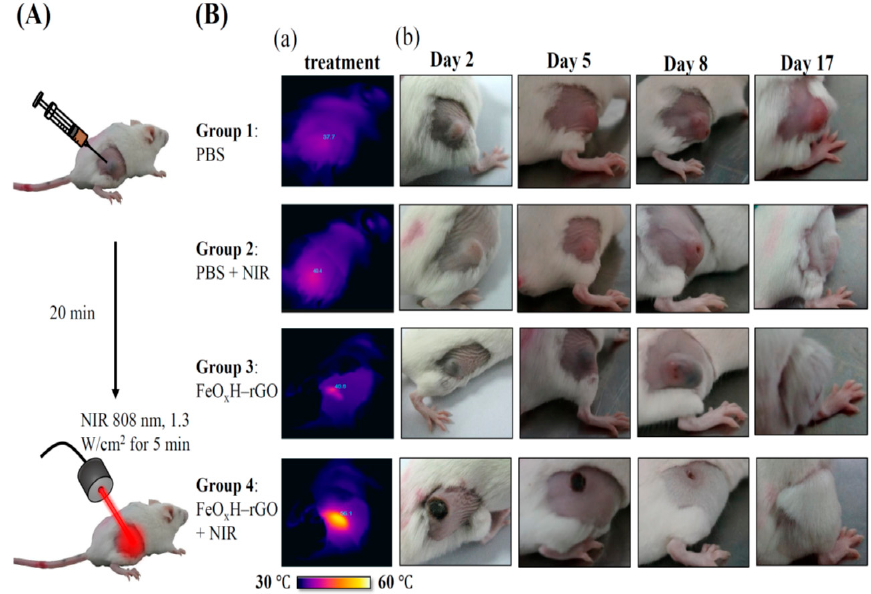
Figure 5. In vivo phototherapeutic effect of FeOxH–rGO nanocomposites. ( A ) Scheme of combination therapy based on intratumorally injected FeOxH–rGO. ( B ) ( a ) IR thermal images of 4T1 tumour-bearing mice recorded by an IR camera, with or without NIR laser irradiation of 5 min, and ( b ) representative photos of mice bearing 4T1 tumours 17 days after treatment. Combined treatment of FeOxH–rGO + NIR laser yielded higher synergistic therapy effect and no tumour recurrence was noted over a course of 17 days. Group 1: PBS; Group 2: PBS + NIR laser; Group 3: FeOxH–rGO; Group 4: FeOxH–rGO + NIR laser.